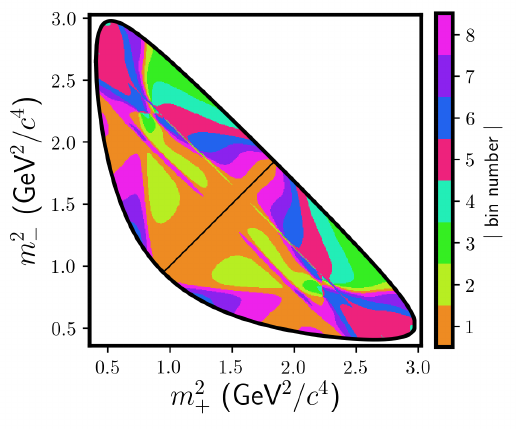
Figure 1 . Dalitz plot of D → K 0